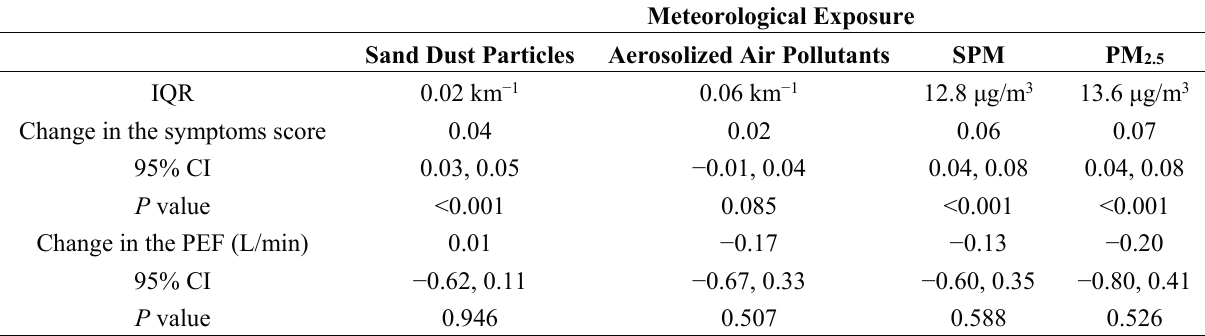
Table 2. Associations of the lower respiratory tract symptom score and PEF to exposure to various environmental